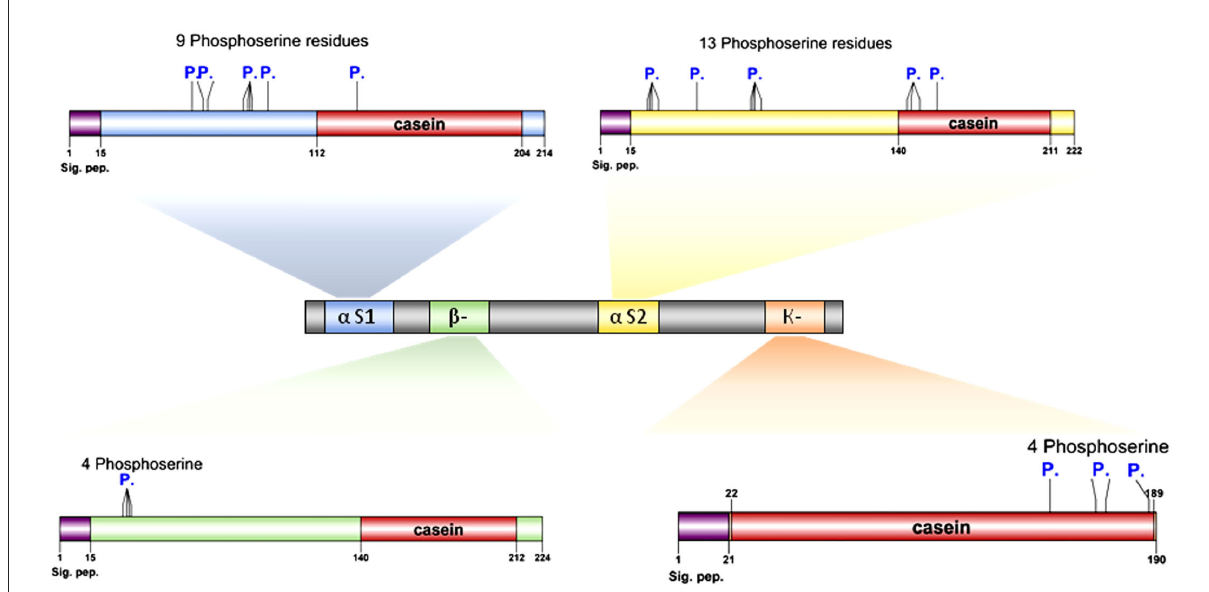
FIGURE7 Proteomic and structural characterization of milk caseins from Bos taurus (cattle). Signal peptide domains (sig. pep.) and phosphorylation sites (P.) are indicated on each protein